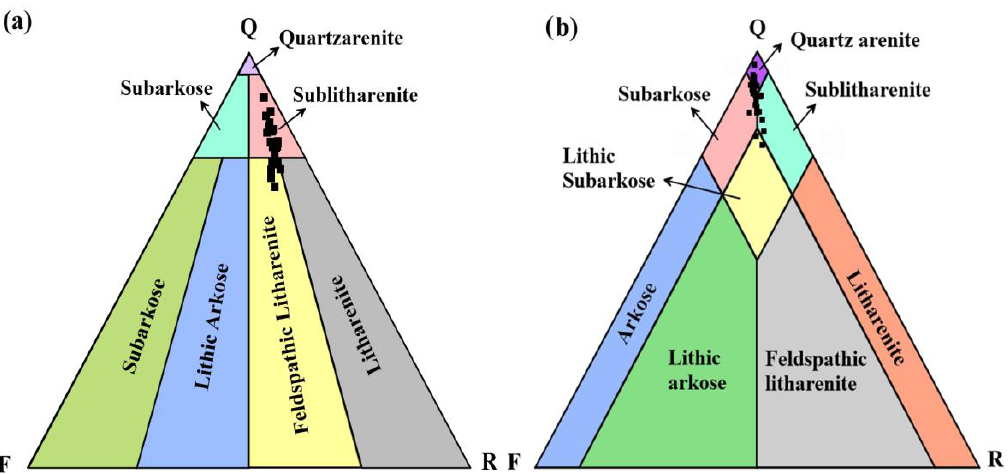
Figure 5. QFR (Quartz-Feldspar-Rock fragments) triangular plot for classification of the studied sandstone samples of Srikail well-3 ( a ) after Folk (1974) [17] and ( b ) after McBride (1963) [18].